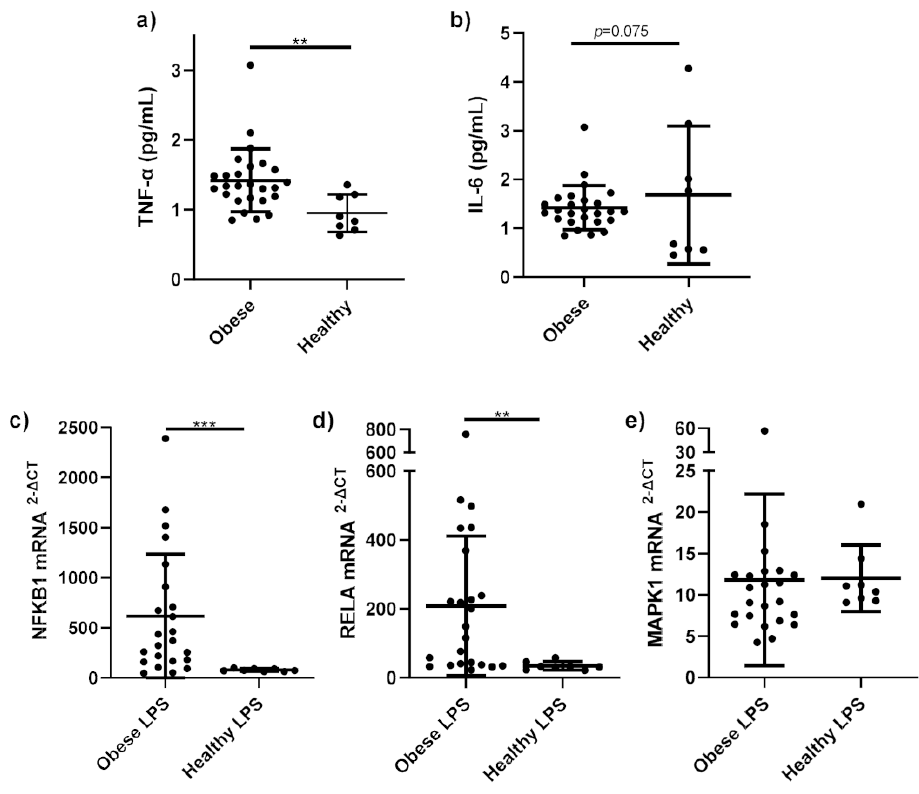
Figure 1. Pro-inflammatory cytokines and gene expression in obese and healthy weight subjects. Serum pro-inflammatory cytokines ( a ) TNF- α (pg/mL); ( b ) IL-6 (pg/mL) and mRNA expression of ( c ) NF κ B1; ( d ) RELA; ( e ) MAPK1 in monocytes stimulated with LPS (1 ng/mL) and incubated